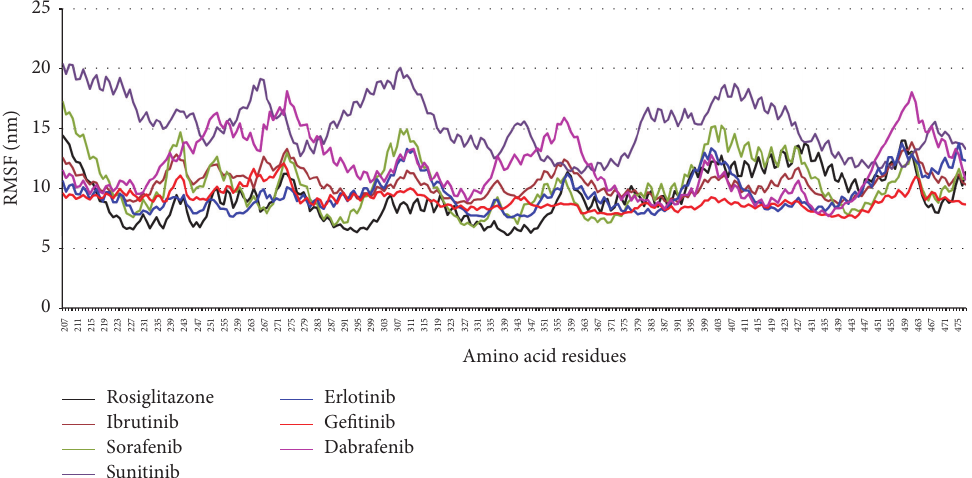
Figure 5: RMSFs for residues 207–476 of human PPAR 𝛾 complexes with KIs and rosiglitazone at 25 ns molecular dynamics